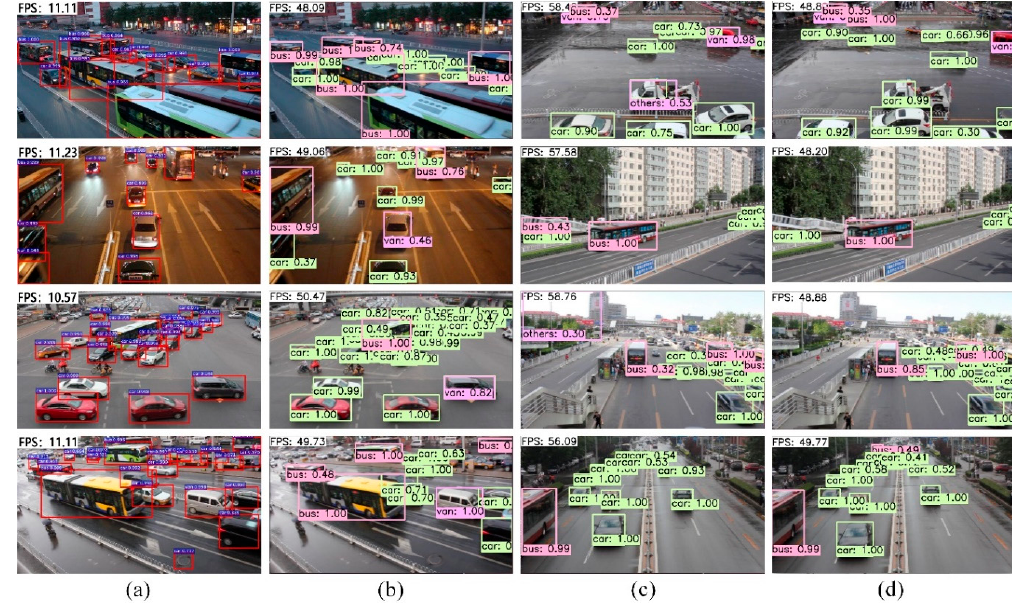
Figure 1. Conventional methods vs. the proposed DP ‐ SSD300 framework on UA ‐ DETRAC dataset. ( a ) Faster R ‐ CNN with low FPS for vehicle detection; ( b ) DP ‐ SSD300 with high FPS for vehicle detection; ( c ) In SSD300, one white vehicle is labeled with two bounding boxes, and some small objects are error detected or miss detected; ( d ) In DP ‐ SSD300, the white vehicle is well labeled, and small objects are well detected.